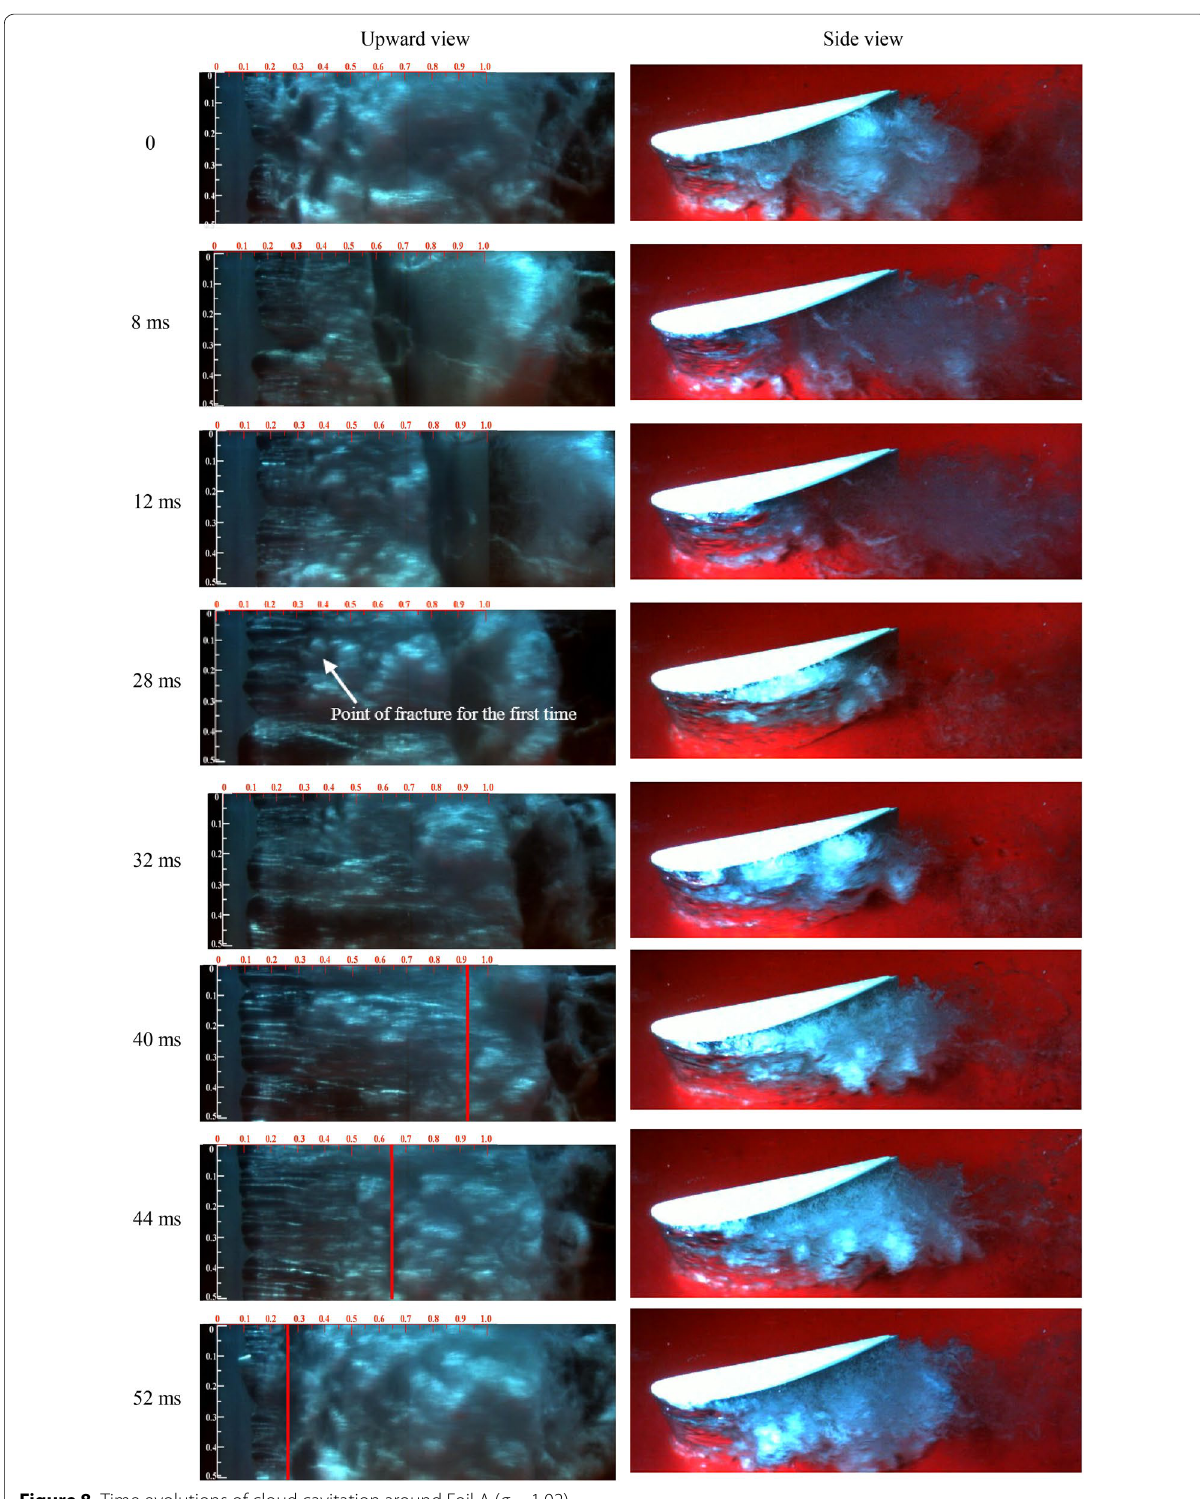
Figure 8 Time evolutions of cloud cavitation around Foil A ( σ